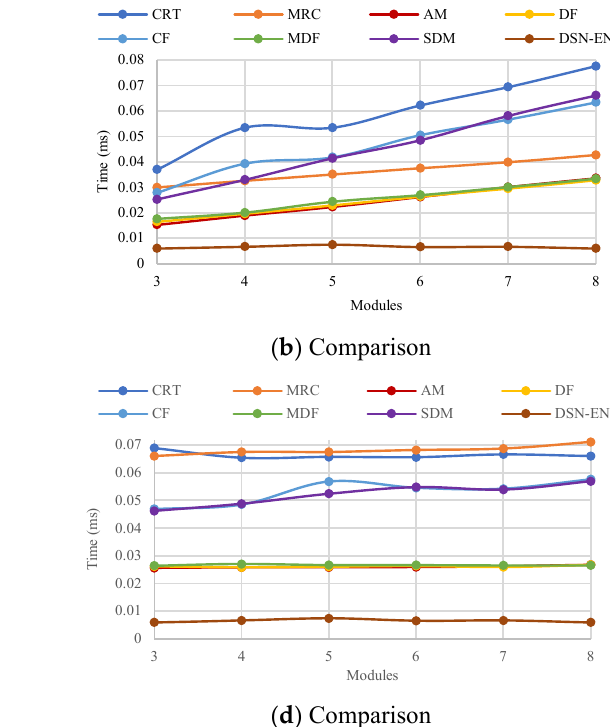
Figure 1. Performance of all methods to ( a ) determine the number’s sign with the dynamic number of modules p , ( b ) compare dynamic numbers of modules p , ( c ) determine the number’s sign with a dynamic bit width, and ( d ) compare numbers with a dynamic bit width.